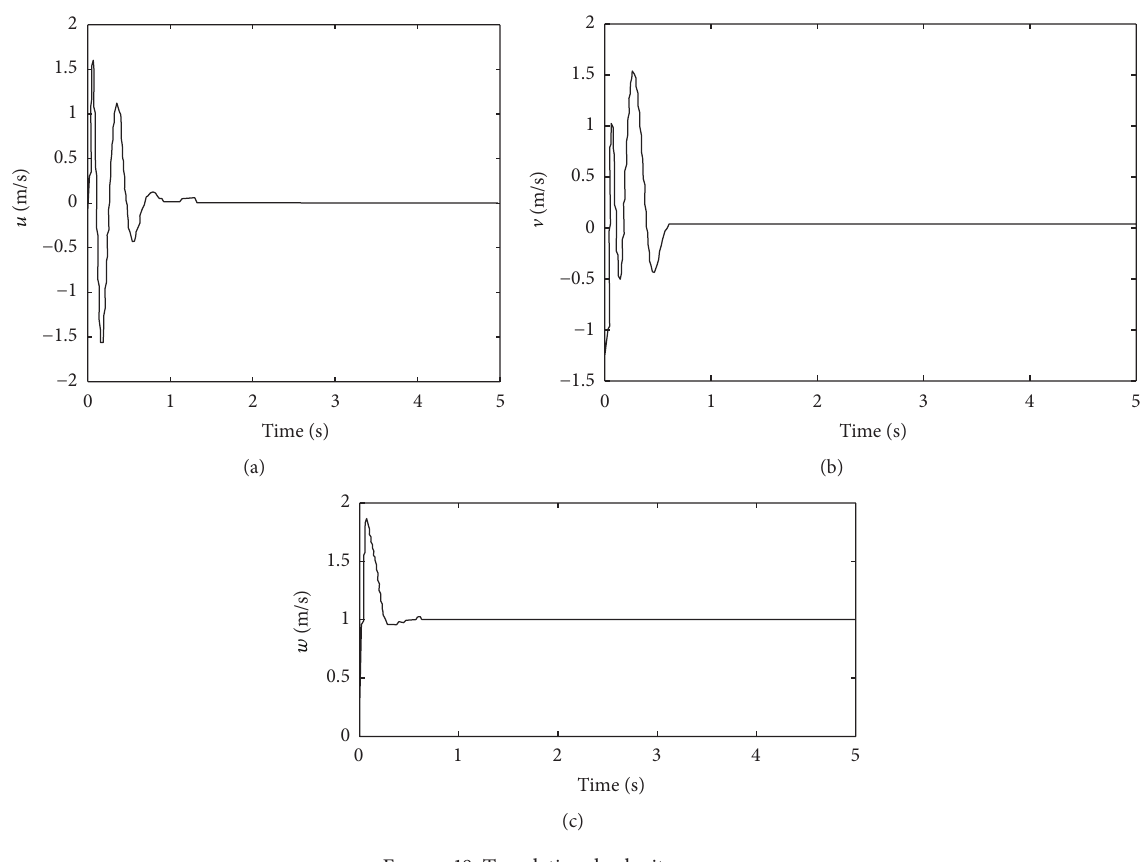
Figure 18: Translational velocity responses.